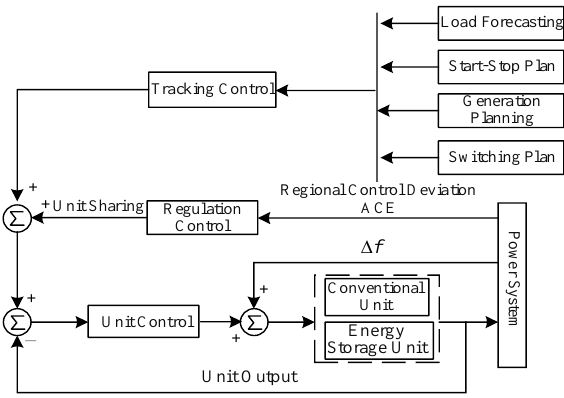
Figure 1. AGC control system structure.